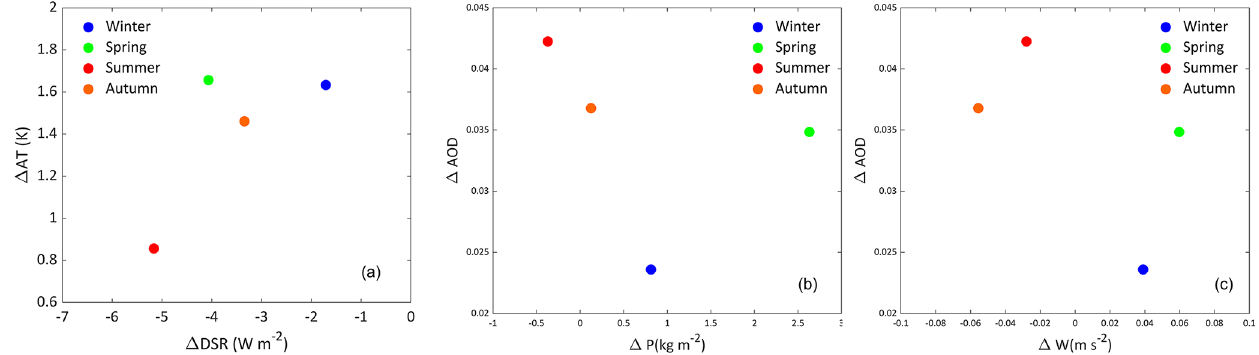
Figure 7. Relationships between variable changed magnitudes at the seasonal scale from 1850 to 2015: (a) the decrease in DSR and increase in air temperature, (b) precipitation change and AOD increase, (c) wind speed change and AOD increase. Data are from the CMIP5 model average.